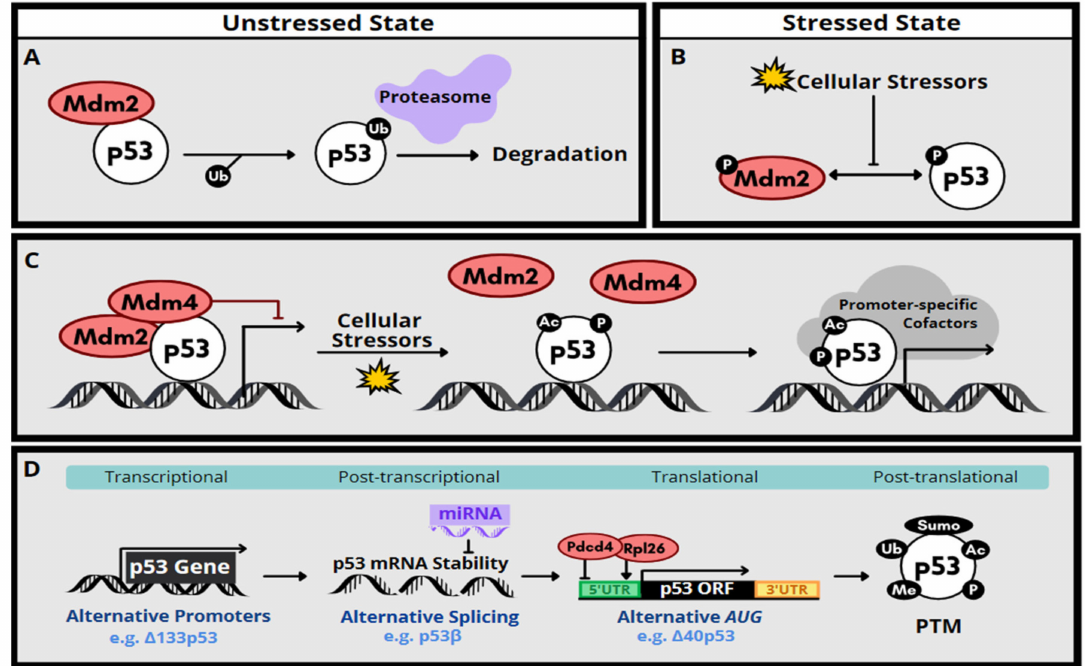
Figure 1. Regulation of p53 gene expression and protein stability/activity. ( A ) In unstressed cells, p53 is subjected to Mdm2- mediated ubiquitination, followed by proteosome-dependent degradation. ( B ) Under stressed conditions, phosphorylation of Mdm2 an p53 prevents their interaction, thereby stabilizing p53. ( C ) Cellular stressors, such as DNA damage, may relieve p53 from Mdm2/Mdm4-mediated suppression from promoters. For full transcriptional activation of p53-responsive genes, p53 may undergo various post-translational modifications and recruit promoter-specific cofactors. ( D ) Depicted are additional molecular mechanisms by which p53 gene/protein expression is regulated. Abbreviations: UTR, untranslated region; ORF, open reading